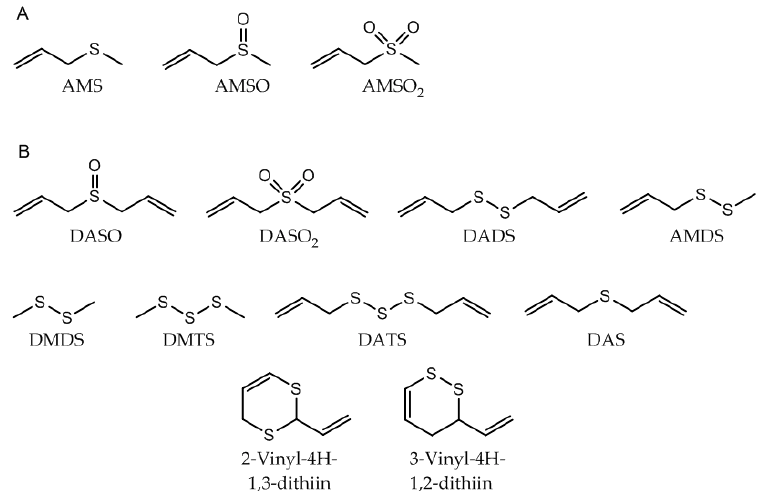
Figure 3. Garlic-associated compounds. ( A ) Detected in human milk after garlic ingestion; ( B ) Not detected in human milk after garlic ingestion. Abbreviations: refer to Table 1.